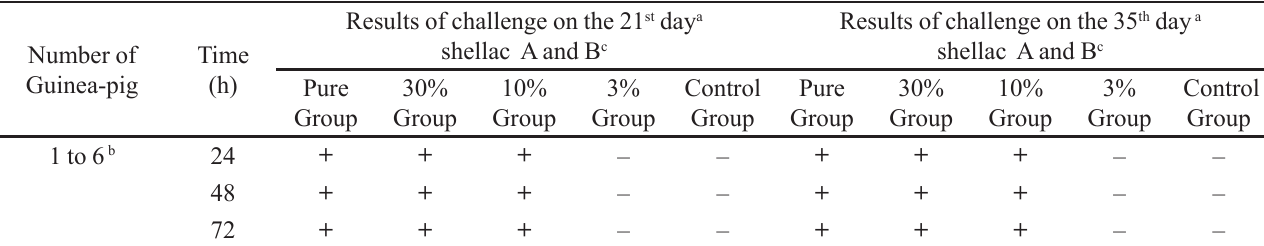
TABLE VIII - Tests of sensitization conducted according to the OET method, after application of two samples (A and B) of a shellac paint, that were undiluted (pure), or 10% and 30% diluted. Six guinea-pigs were used as tests for each shellac, as well as 6 guinea- pigs as the corresponding shellac-free controls